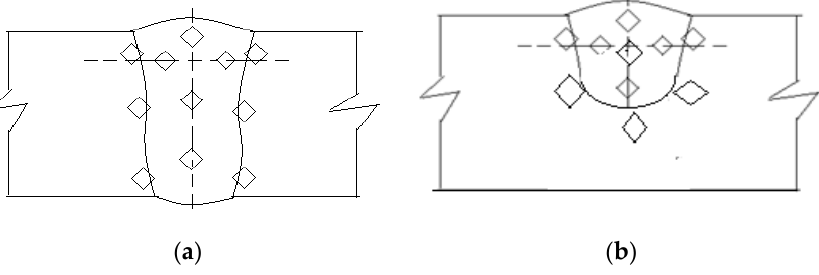
Figure 5. Hardness test locations in the FZ and HAZ of ATIG ( a ) and TIG ( b ).